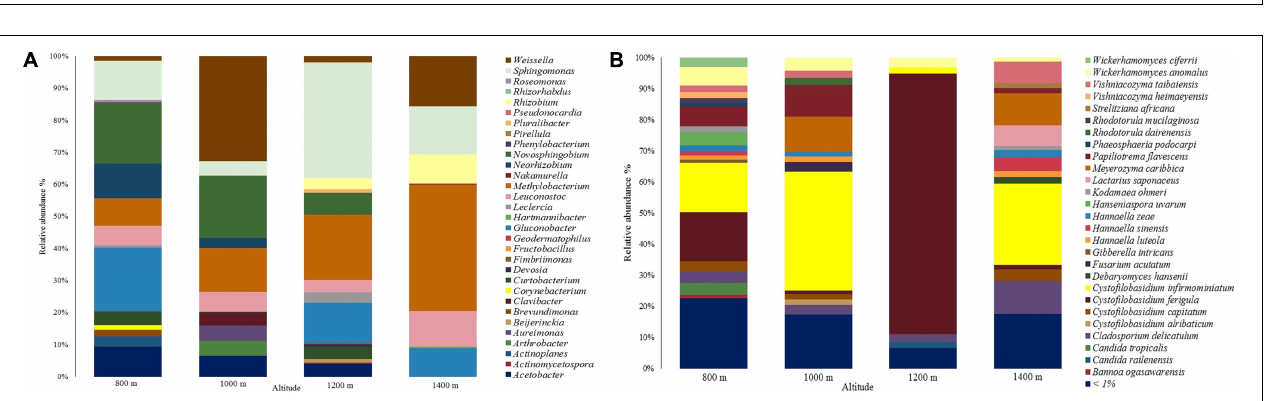
at 1,000 m, Beijerinckia , Pluralibacter , Actinomycetospora